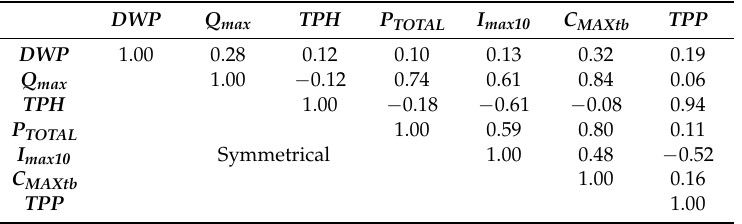
Table 8. Correlation matrix for variables of rainfall events at San Felix Catchment.